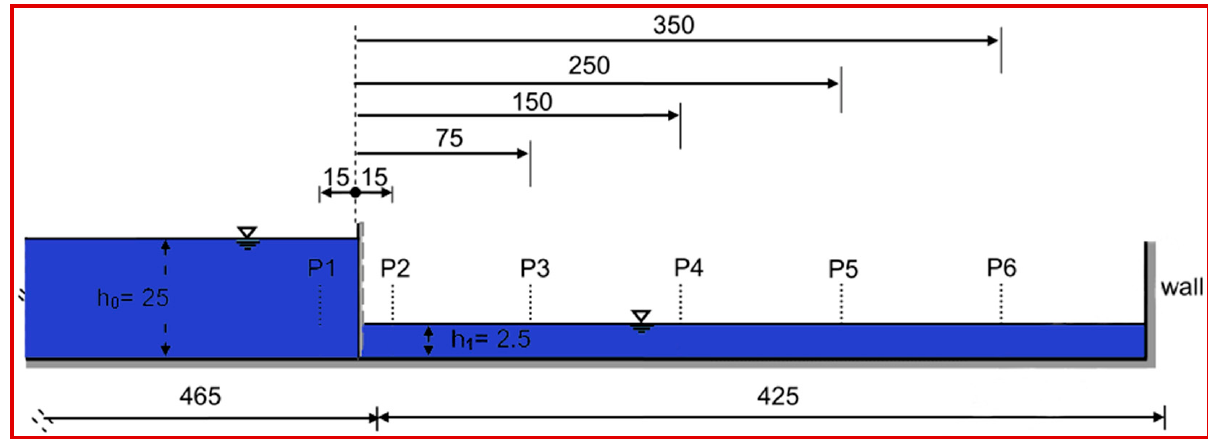
Figure 12. Calculation model with wet bed.